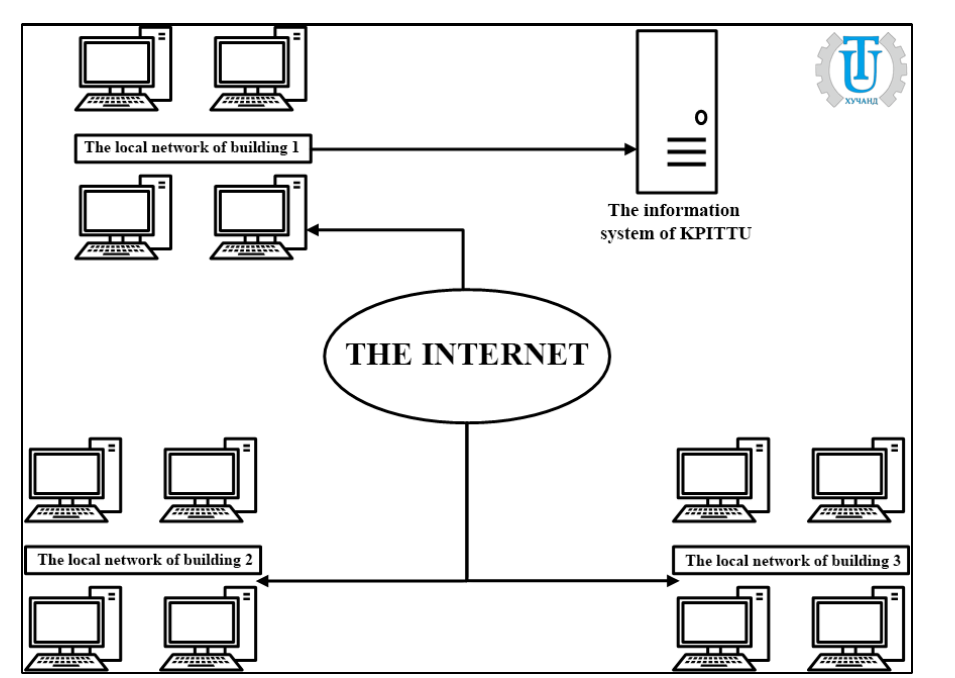
Fig. 3. Management information system architecture.